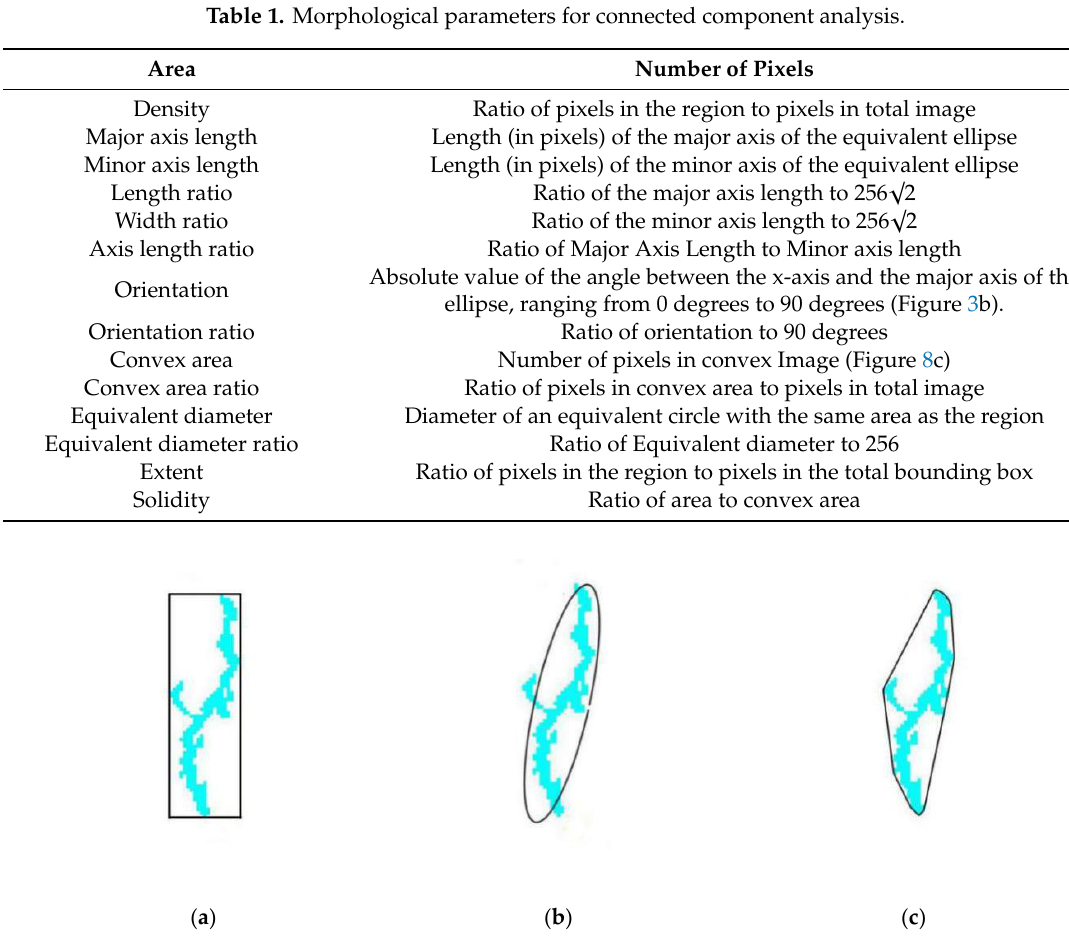
Figure 8. Morphological parameters. ( a ) Bounding box, ( b ) bounding ellipse and (c ) convex hull.